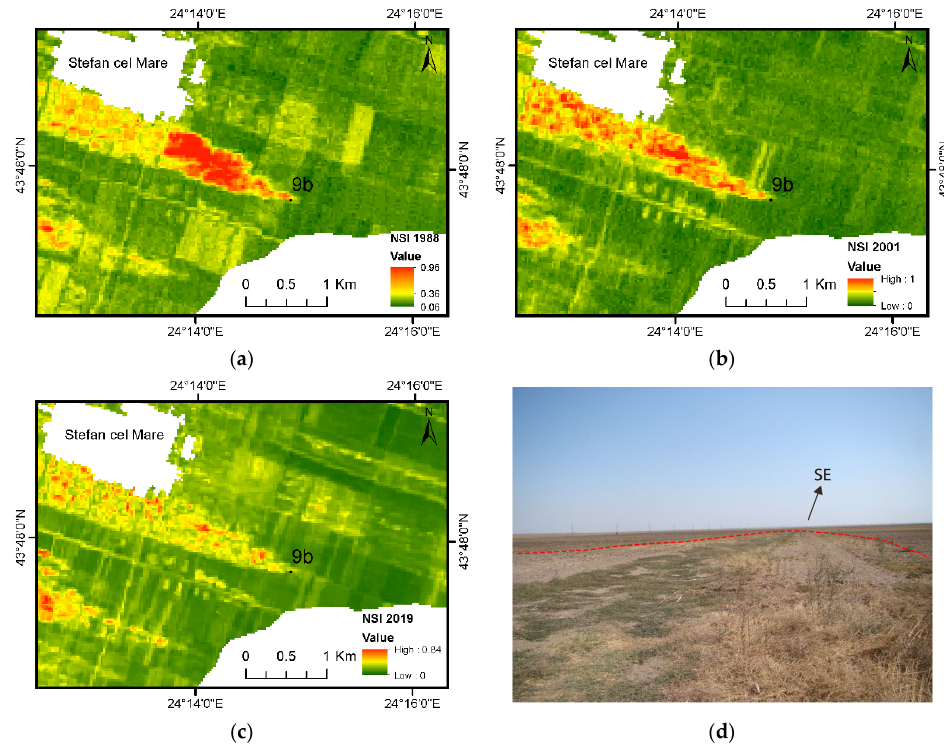
Figure 9. Evolution of sands evidenced by NSI in the vicinity of point 9b in 1988 ( a ), 2001 ( b ), and 2019 ( c ); ( d ) photo of a sample point location (2019). In the areas where the dunes were modelled, the unaltered sand brought to the surface had high reflectivity, as was the NSI value for 1988 (Figure 10a). Over time, the alteration and accumulation of organic matter attenuated the NSI value (2001), and through land cover, bare sands became less identifiable (Figure 10c).